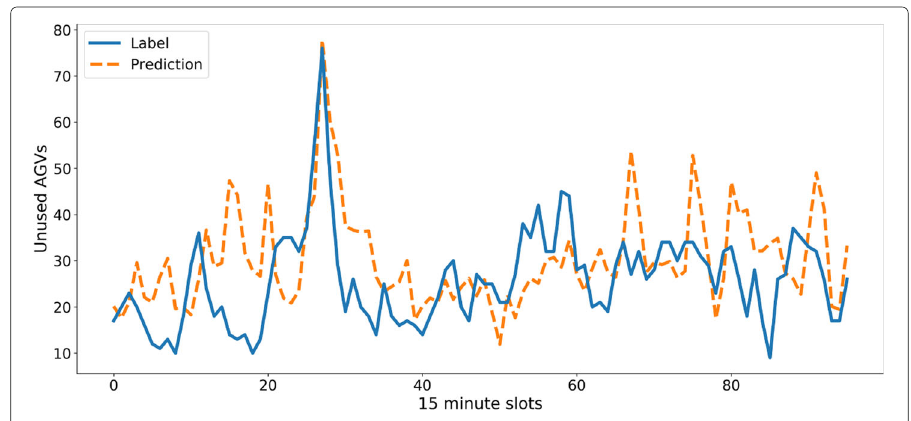
Fig. 7 Example AGV usage prediction on unseen